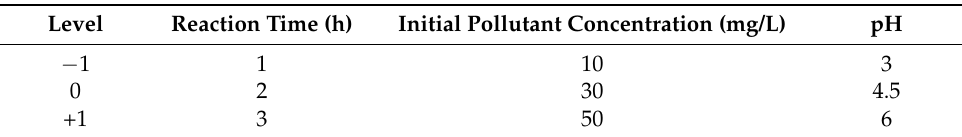
Table 1. Independent variables of the three-level factorial